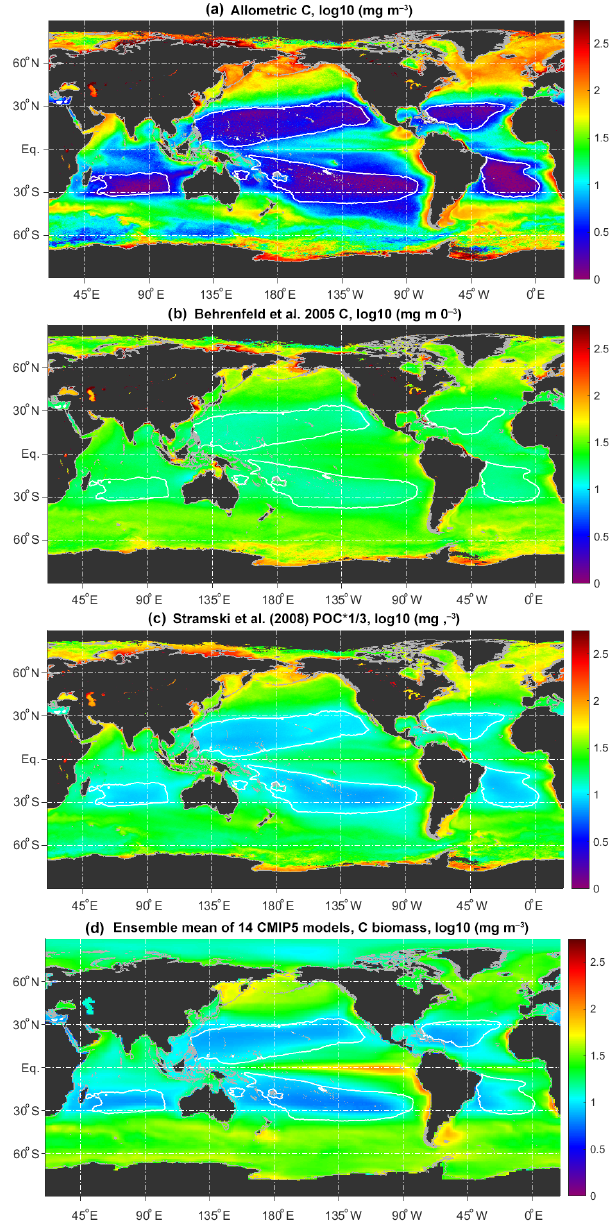
Figure 1. SeaWiFS mission composite mean (September